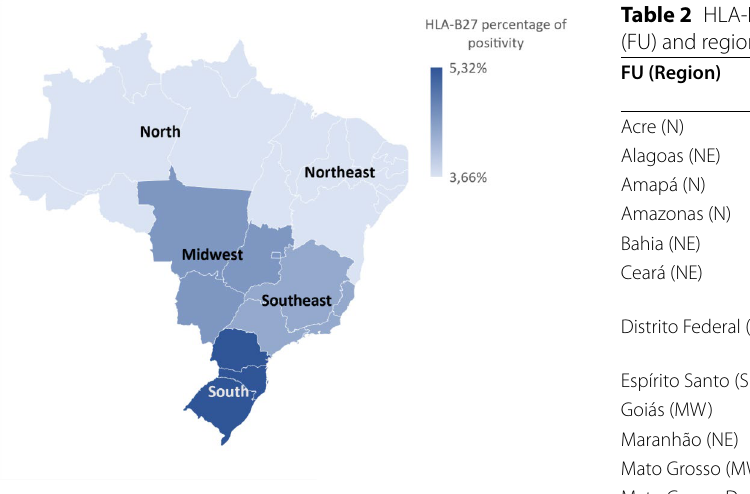
Fig. 4 HLA-B27% of positivity in the general healthy population, accord- ing to region of residence in Brazil (from REDOME database)